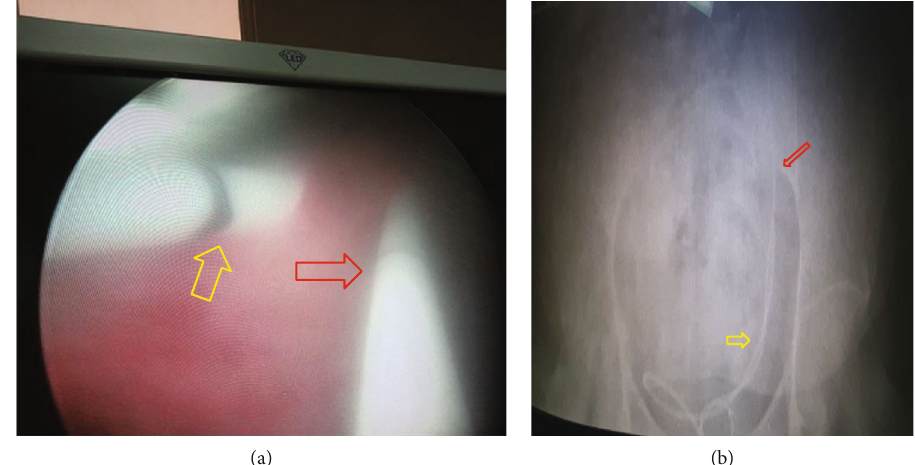
Figure 2: (a) Preoperative cystoscopy showing the two left ureteric ori fi ces where the medial is allowing JJ stent placement (yellow arrow) and the lateral one is intubated with a ureteric catheter (red arrow) (obstructed ureter). (b) KUB shows the two catheters where the lateral could not go beyond the mid sacrum because of ureteric stone (yellow arrow) and normally placed (red arrow) JJ